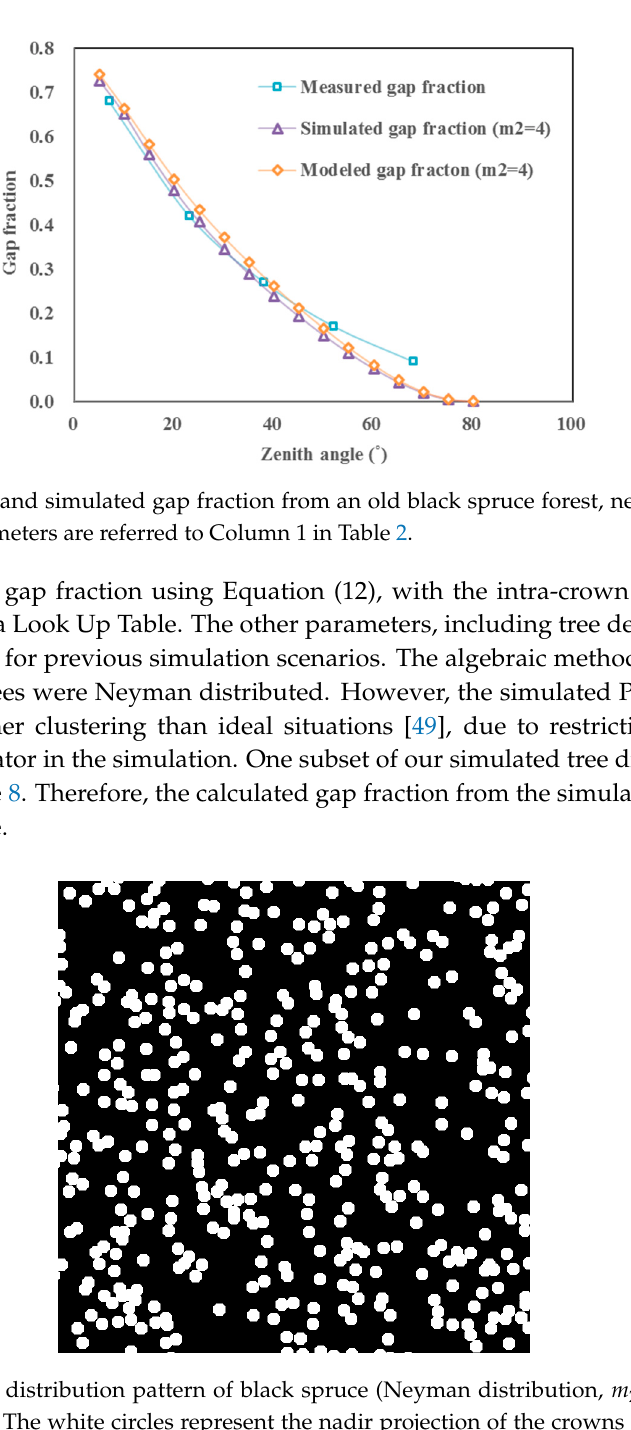
Figure 6. Relative discrepancy between simulated and modeled crop clumping index for different zenith angles at specific azimuth angles.